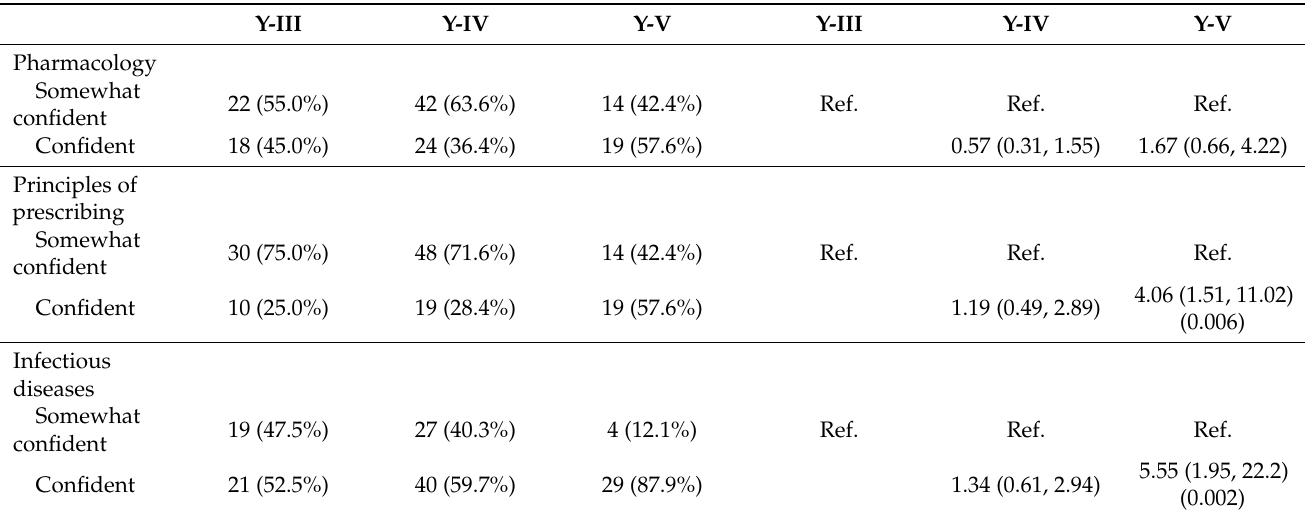
Table 8. Frequency and odds of student years in confidence in prescribing knowledge.